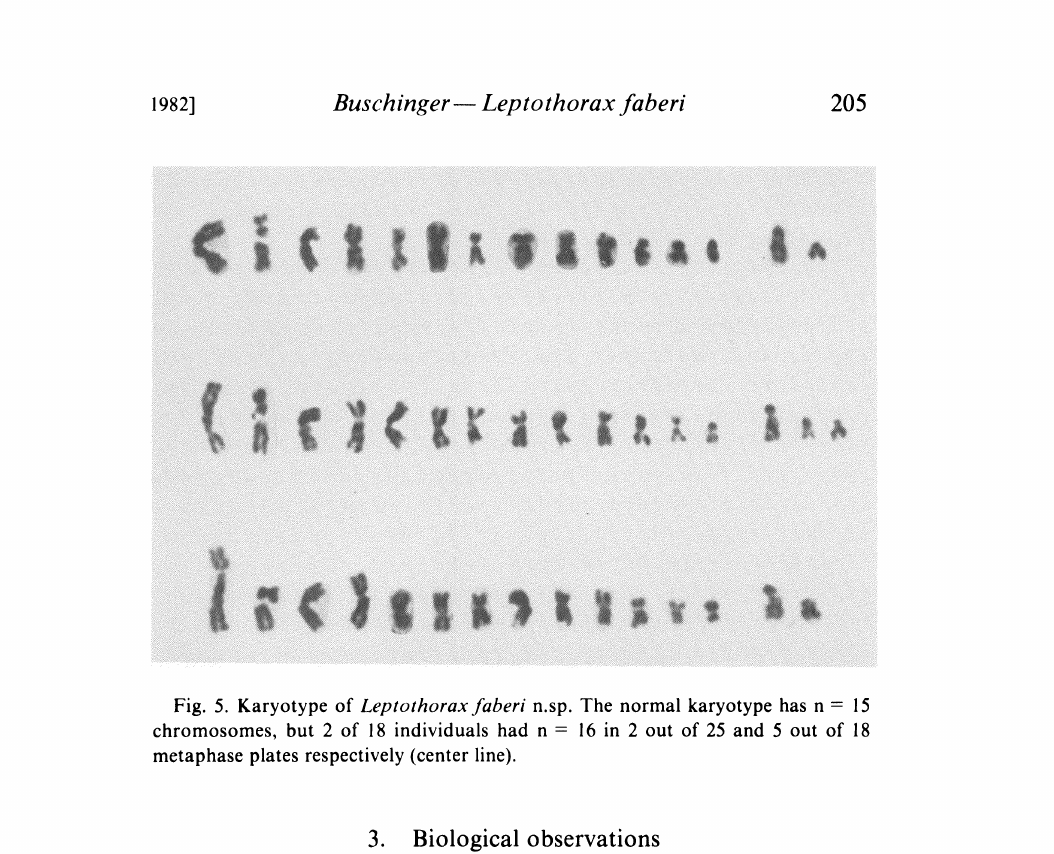
Fig. 5. Karyotype of Leptothoraxfaberi n.sp. The normal karyotype has n 15 chromosomes, but 2 of 18 individuals had n 16 in 2 out of 25 and 5 out of 18 metaphase plates respectively (center